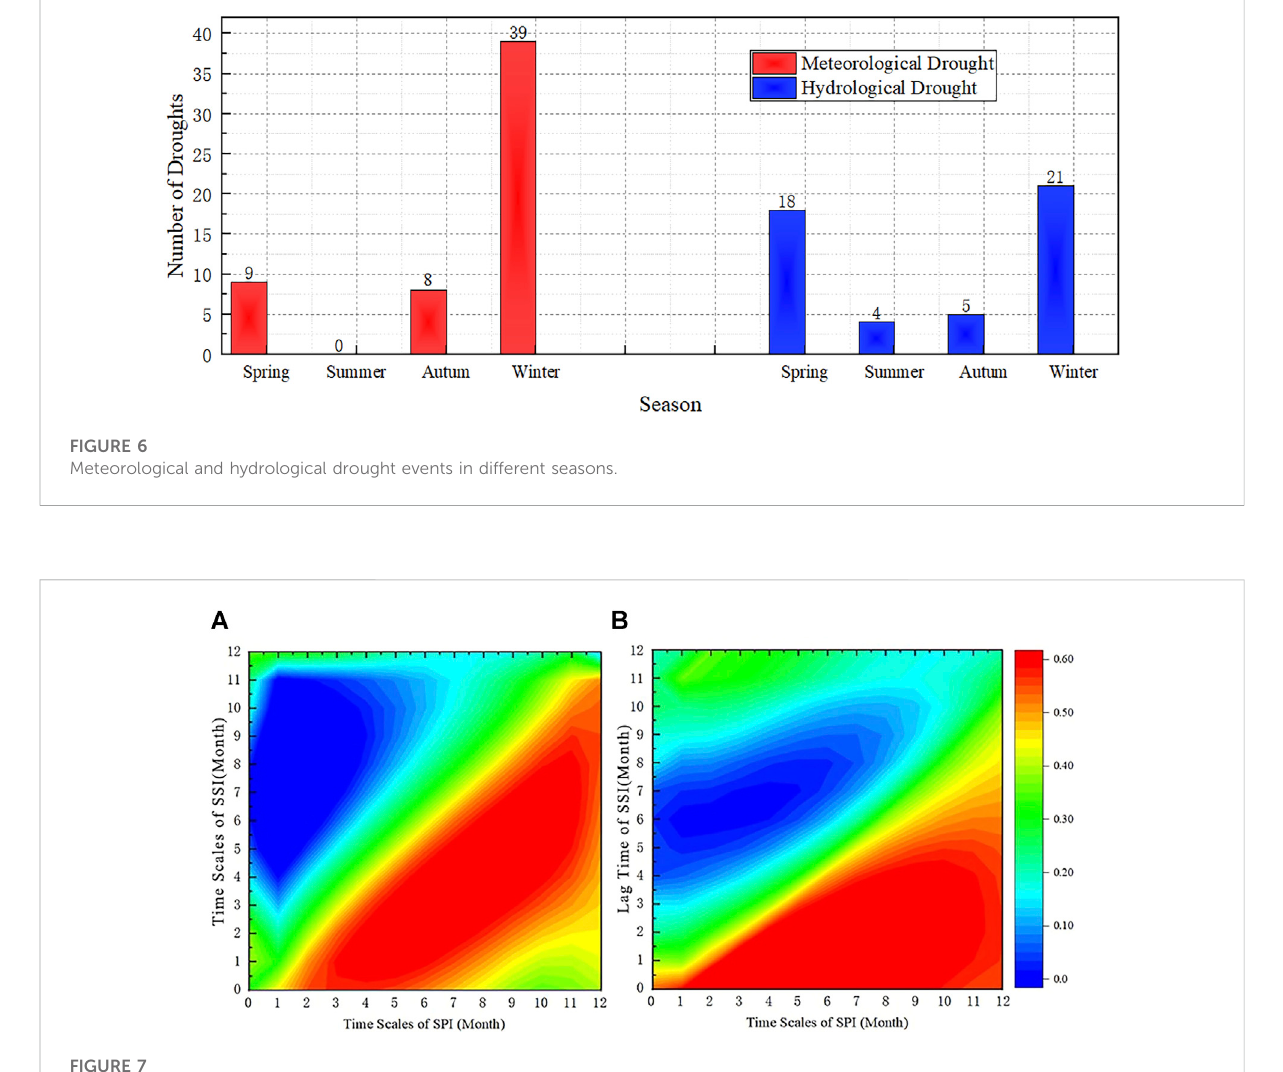
Frontiers in Earth